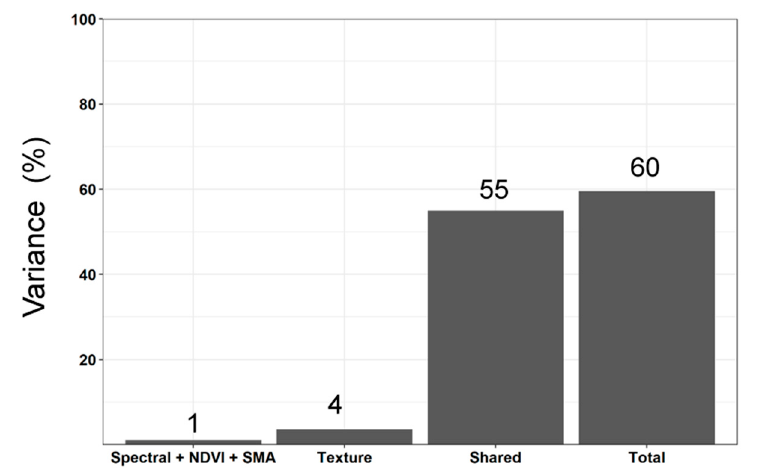
Figure 4. Results of the variance partitioning analysis for predicting tree species deciduousness from spectral and texture information calculated from Sentinel-2 imagery. The spectral information includes reflectance of spectral band, NDVI, and SMA deciduousness fraction.